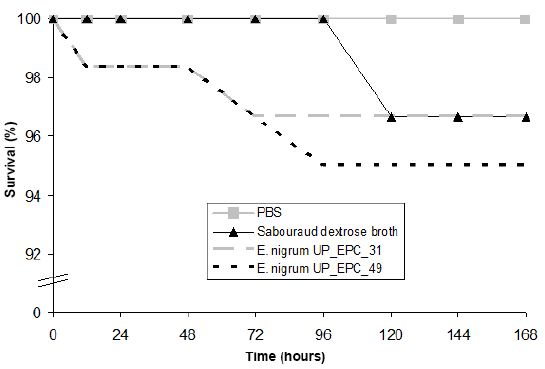
Figure 2 The effect of Epicoccum nigrum UP_EPC_31 and UP_EPC_49 secondary metabolites on the survival of Galleria mellonella larvae. PBS and SDB medium were used as the